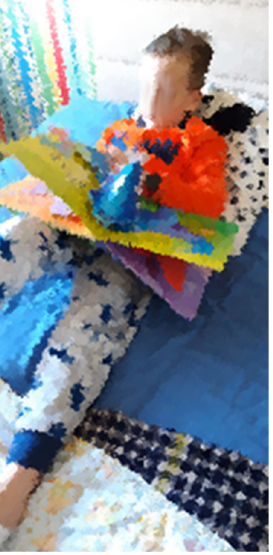
Figure 8. David ready for bed.